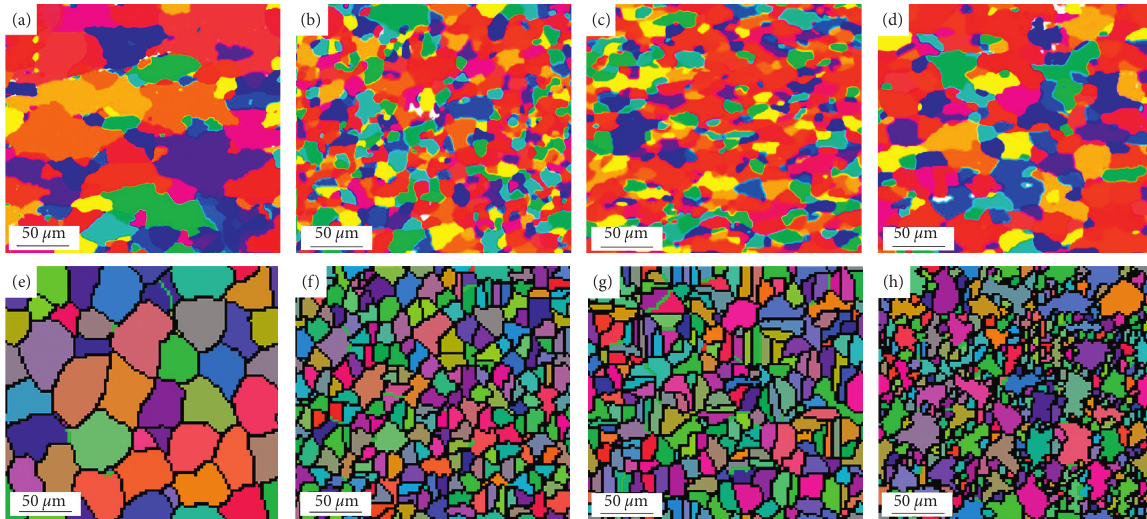
Figure 2: The grain images in the axial center of the cylindrical samples compressed at 350 ° C with (a) no strain rate (raw structure); (b) compressive strain rate of 0.01 s − 1 ; (c) compressive strain rate of 0.1 s − 1 ; (d) compressive strain rate of 1.0 s − 1 . The CA simulated microstructure of samples compressed at 350 ° C with (e) no strain rate; (f) compressive strain rate of 0.01 s − 1 ; (g) compressive strain rate of 0.1 s − 1 ; (h) compressive strain rate of 1.0 s − 1